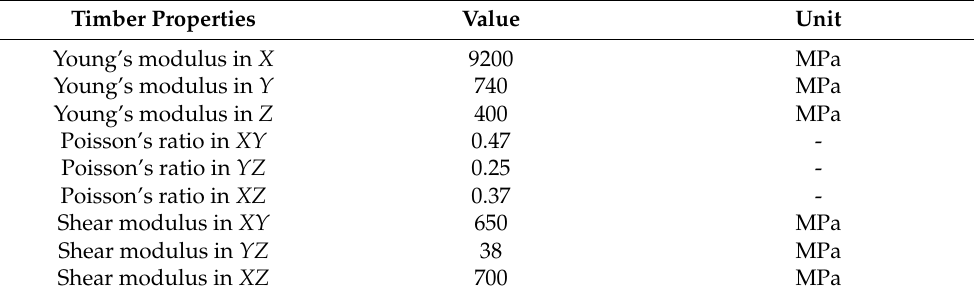
Table 2. Elastic constants of the material model for timber; see Johanides 2022 [44]. Timber Properties